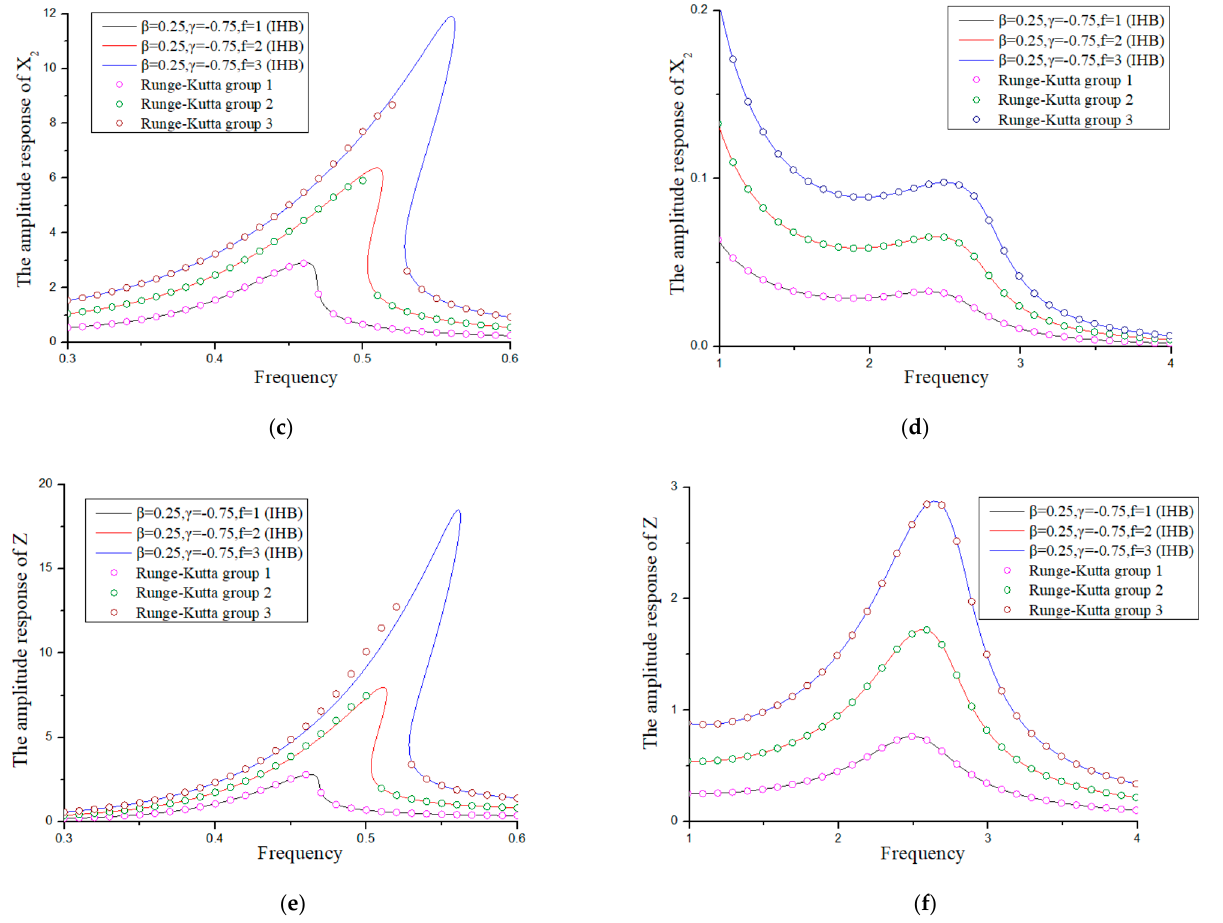
Figure 7. Amplitude – frequency characteristic curve of the isolation structure under different Figure 7. Amplitude–frequency characteristic curve of the isolation structure under different excitation amplitudes (when excitation amplitudes (when =0.25 = 0.75 β γ − ， ) ( a , b ) Amplitude – frequency characteristic curve β = 0.25, γ = − 0.75) ( a , b ) Amplitude–frequency characteristic curve of the substructure; ( c , d ) Amplitude–frequency of the substructure; ( c , d ) Amplitude – frequency characteristic curve of the superstructure; ( e , f ) characteristic curve of the superstructure; ( e , f ) Amplitude–frequency characteristic curve of the hysteretic Amplitude – frequency characteristic curve of the hysteretic element.